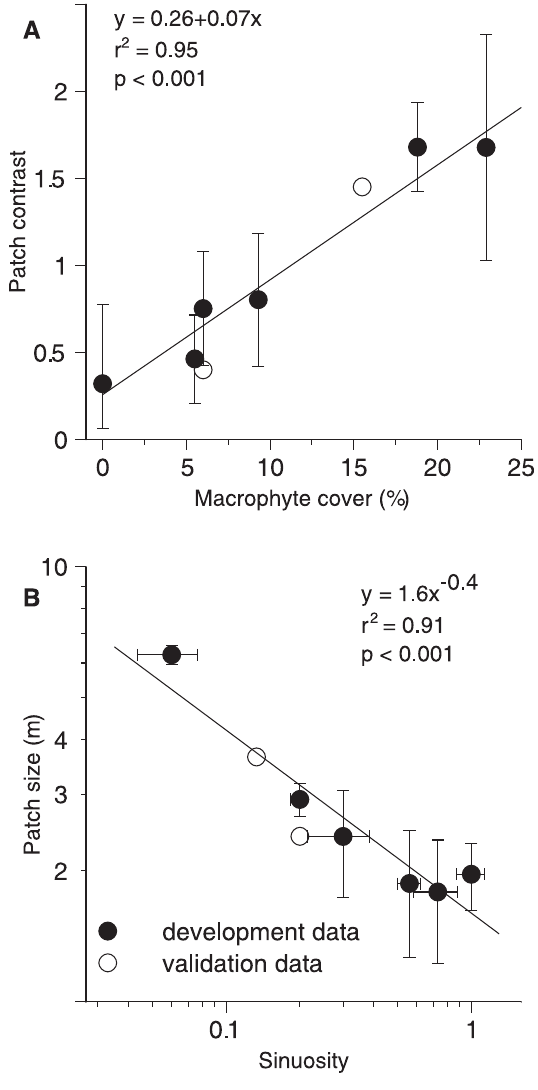
Figure 5. Models to predict patch contrast and patch size. Correlations of normalized patch contrast of hyporheic parameters with the submerged macrophyte cover (A) and correlation of mean patch size of hyporheic parameters with the sinuosity for a 1.5 km long stretch upstream of the sampling site (B). Note the logarithmic scale for (B). Means of patch contrasts and patch sizes were calculated for each stream over both sampling dates and three (pH, specific conductance, dissolved oxygen) parameters (n=6). Vertical bars show the respective standard deviation. Horizontal bars in (B) display the range in sinuosity for 0.5 to 2 km long stretches. Closed circles denote the development data, open circles denote the validation data. Statistics have been calculated without validation